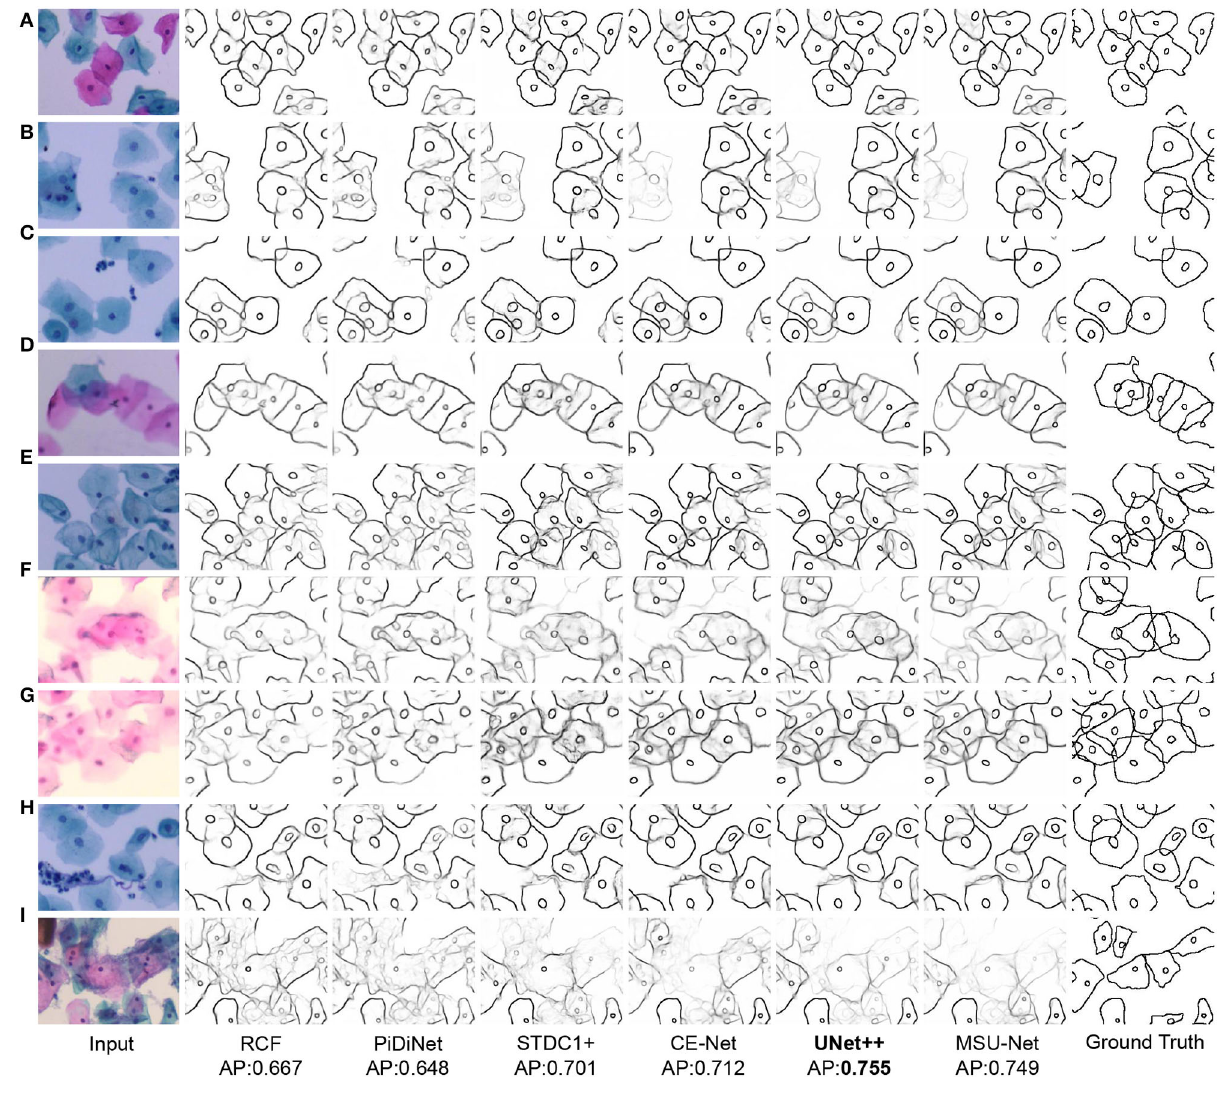
accurate edge detection of overlapping cervical cells. We analyze several factors affecting the performance of overlapping edge